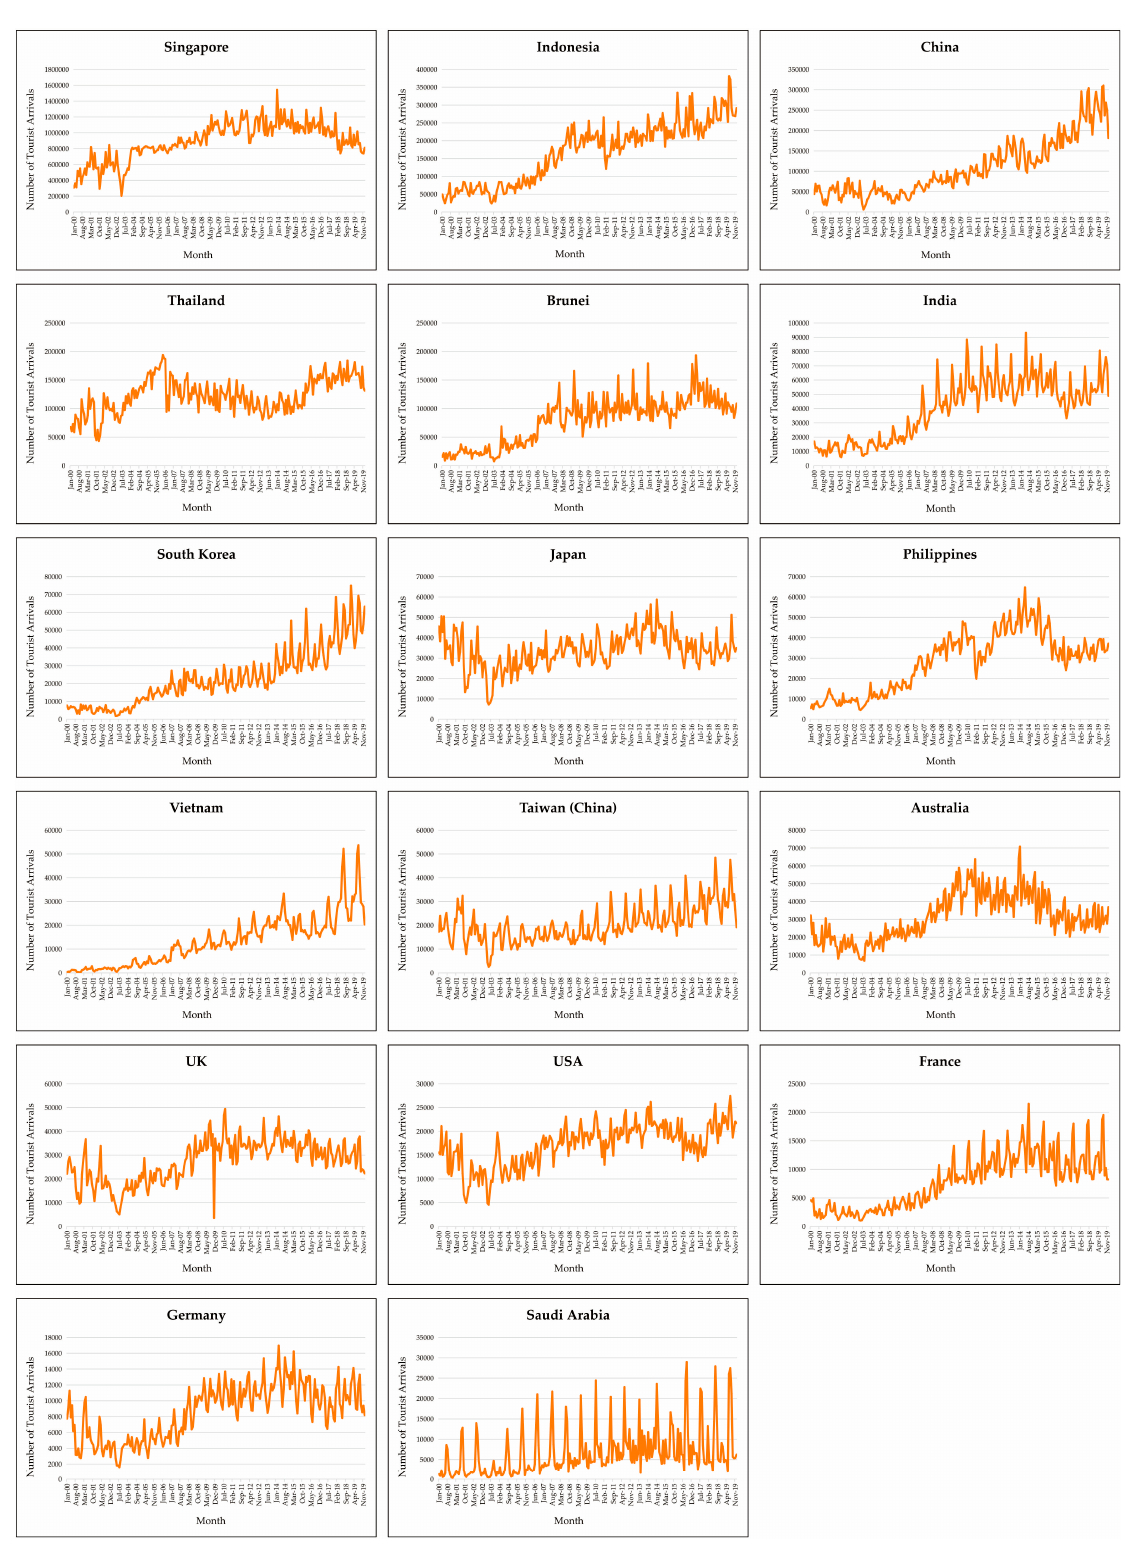
Figure 1. Seventeen monthly tourist arrivals into